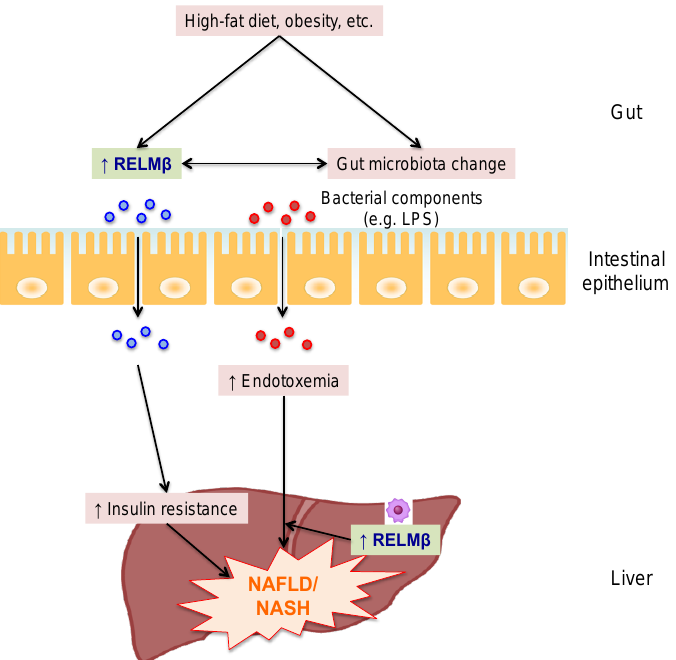
Figure 1. The proposed role of RELM β in the pathogenesis of NAFLD/NASH. Intake of a high-fat diet and obesity increase both intestinal expression and circulating levels of resistin like molecule β (RELM β ). Circulating RELM β elicits insulin resistance, and increased gut-derived RELM β and gut microbiota appear to regulate each other, thereby increasing translocation of the endotoxin lipopolysaccharide (LPS) from the intestine into the bloodstream and liver, which induces hepatic steatosis and inflammation. In the liver, RELM β in Kupffer cells exacerbates hepatic inflammation, along with endotoxemia, which further worsens non-alcoholic fatty liver disease (NAFLD)/non-alcoholic steatohepatitis